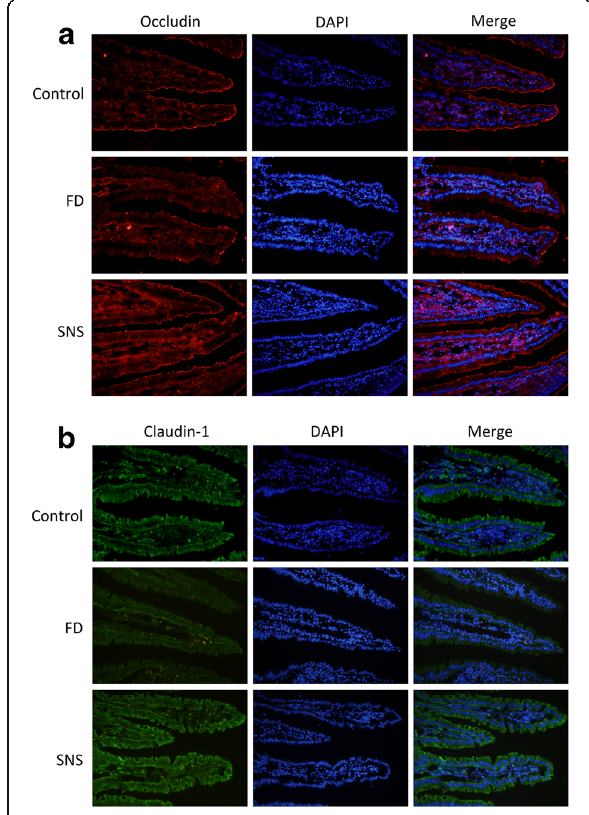
Fig. 4 Representative photomicrographs of immunofluorescence of occluding ( a ) and claudin-1 ( b ). These pictures showed a decline in the expression of both occluding and claudin-1 in the model group, which was restored in response to SNS